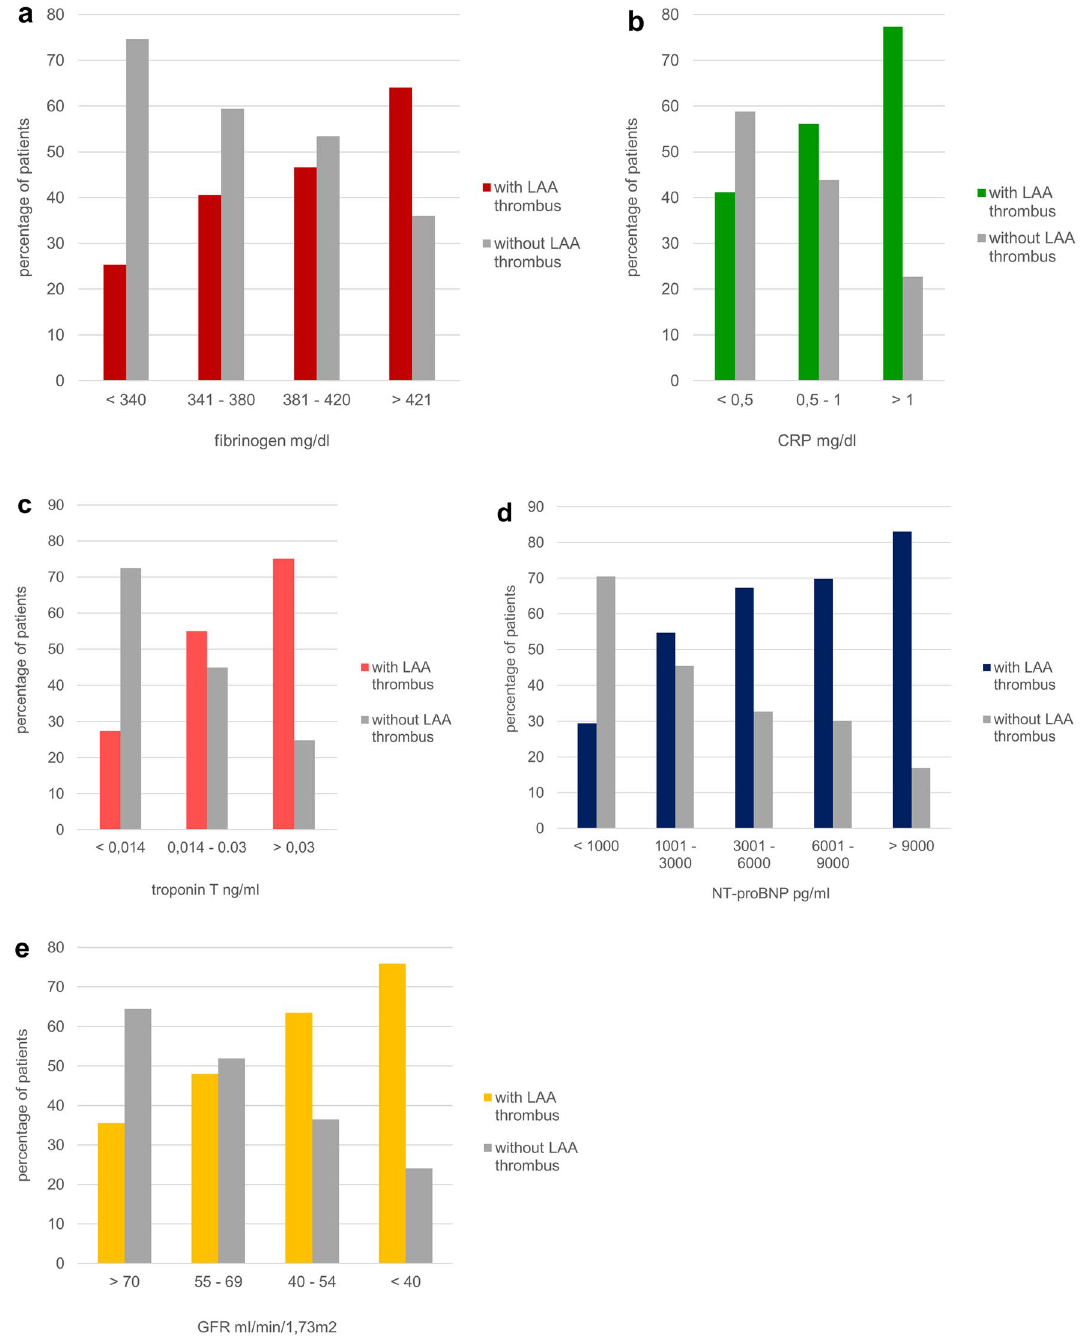
Figure 2. Correlation between different fibrinogen ( a ), C- reactive protein (CRP) ( b ), troponin T ( c ) and NT-proBNP ( d ) concentrations in serum and percentage of patients with and without LAA thrombus . Correlation between different Glomerular filtration rate (GFR) levels and percentage of patients with and without LAA thrombus ( e values had increased during observation period. The percentage of patients without effective anticoagulation at the day of last admission was 12% in the group with persistent thrombus and 22.2% in the group with dis- solved LAA thrombus. In these cases, patients were advised by their physicians to stop their oral anticoagula- tion 2–3 days before admission to minimize bleeding risk for expected invasive procedures. Duration of oral anticoagulation between first and last hospital visit did not statistically differ between patients who dissolved their LAA thrombi and those, who did not (145 ± 215 vs. 184 ± 222 days, p = 0.139).